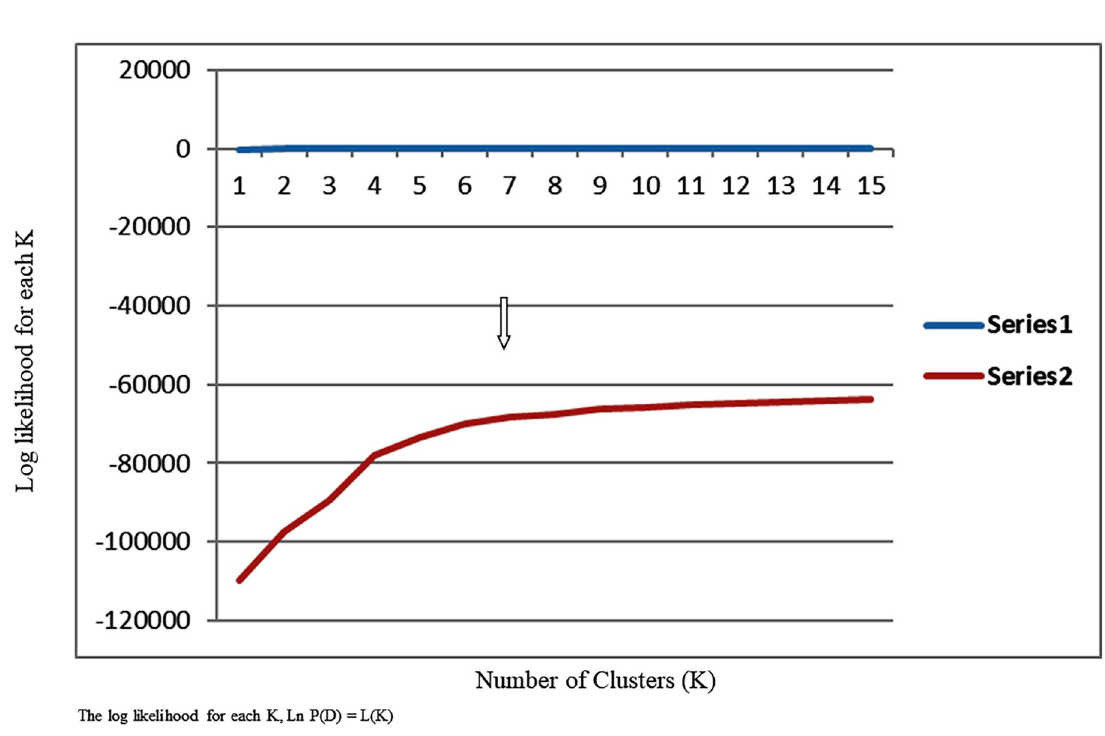
Fig 3. Plot of log of K versus number of clusters based on STRUCTURE analysis. Analysis of population structure of 421 cacao accessions using STRUCTURE—estimated Ln P (K) of possible clusters ( K ) from 2 to 15. When K is approaching a true value, L( K ) plateaus (or continues increasing